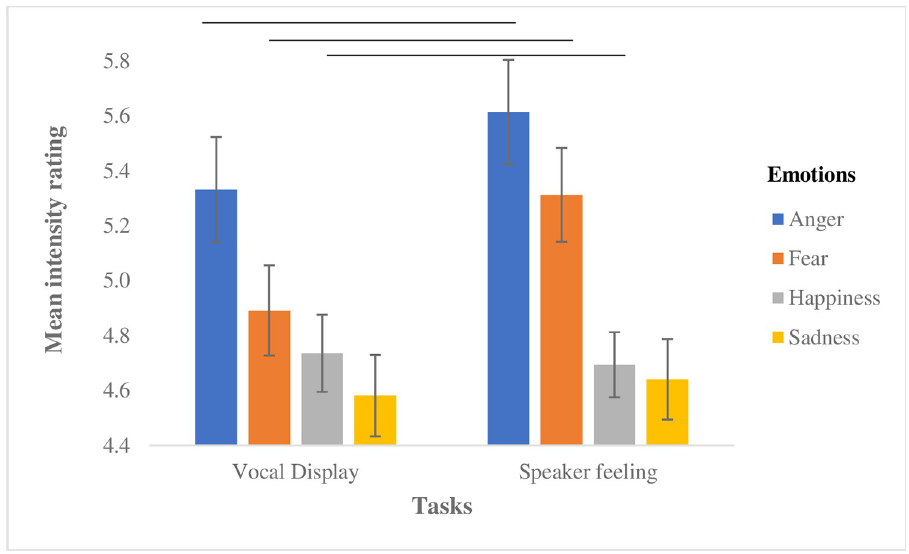
Fig 2. Perceived intensity of vocal expressions by emotion type for the display and feeling tasks. The black lines above the bar graphs represent significant comparisons between different emotions.